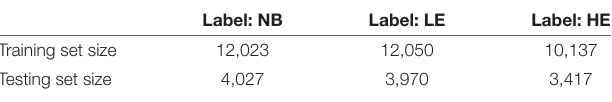
TABLE 1 | Number of ROIs, according to truth label, used for training and testing of